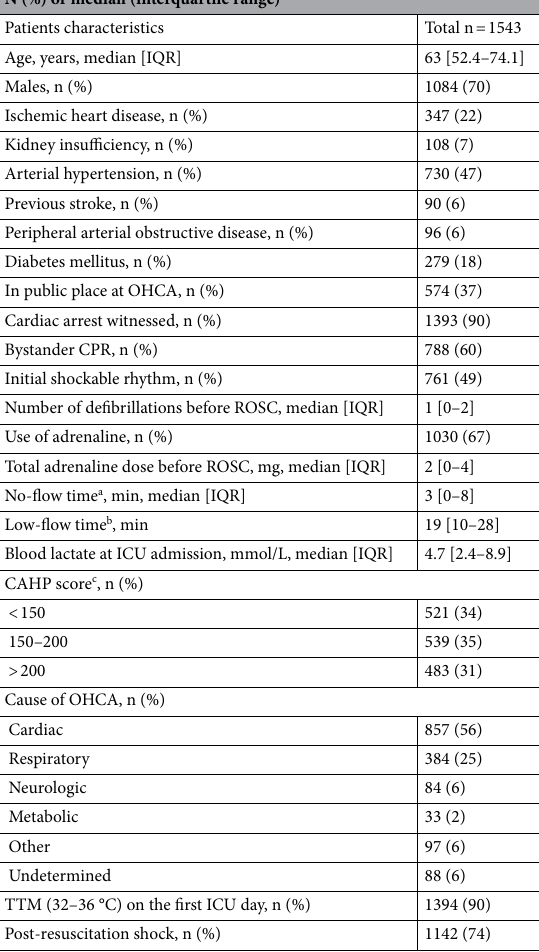
Table 1. Main characteristics in 1543 included patients with sustained return of spontaneous circulation after cardiac arrest. IQR interquartile range, OHCA out-of-hospital cardiac arrest, CPR cardiopulmonary resuscitation, ROSC return of spontaneous circulation, CAHP Cardiac Arrest Hospital Prognosis, TTM targeted temperature management. a No-flow time was defined as the time from collapse to cardiopulmonary resuscitation initiation. b Low-flow time was defined as the time from cardiopulmonary resuscitation initiation to the return of spontaneous circulation. c CAHP scores are divided into three risk categories: < 150, low risk; 150–200, moderate risk; and > 200, high risk of poor